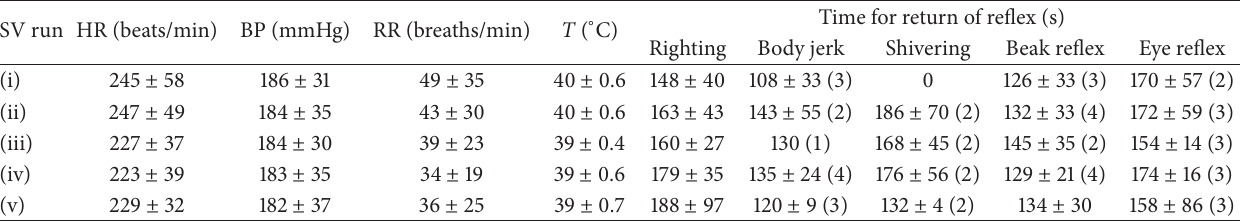
Numbers in parentheses indicate the number of birds where the reflex was observed. Table 2: Mean ± SD values for venous blood hydrogen ion concentration (pH), carbon dioxide partial pressure (pCO ), bicarbonate (HCO 3− ), base excess (BE), and haemoglobin oxygen saturation (O pressure (pO 2